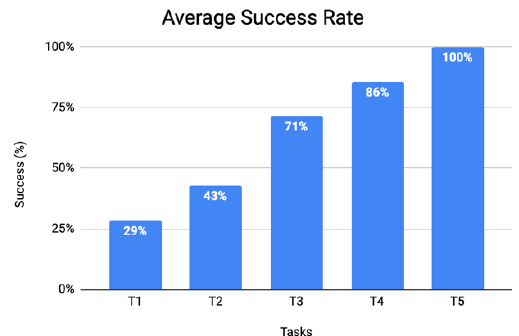
Figure 12. Average success rate for the mobile application usability session.